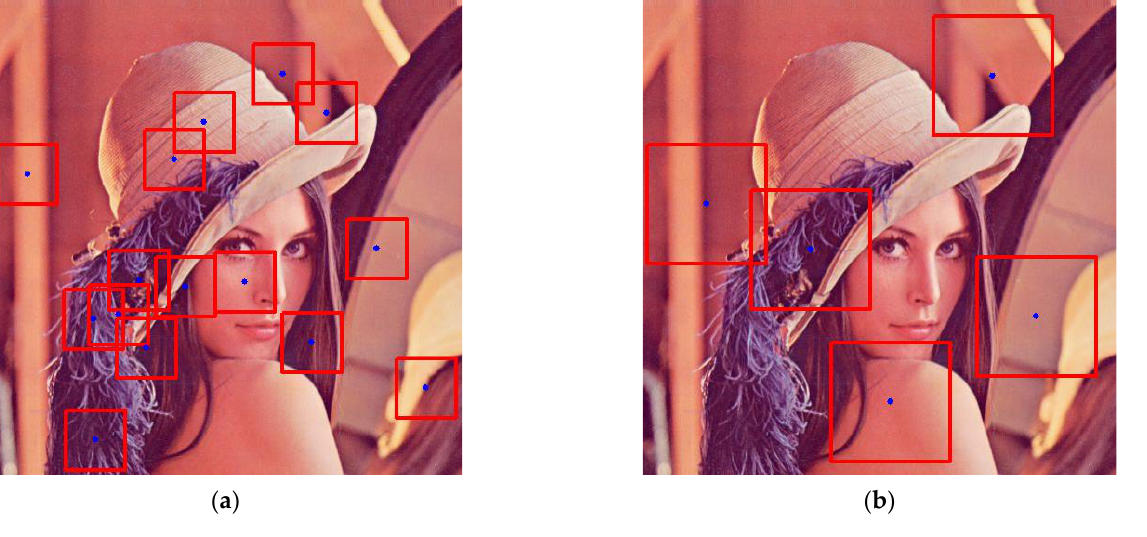
Figure 3. Creating random patches: ( a ) 15 patches with dimensions of 64 × 64 randomly positioned all over the source image (overlapping of patches is allowed); ( b ) 5 patches with dimensions of 128 × 128 randomly positioned all over the source image (overlapping of patches is allowed for up to 10% of the patch’s area, and a maximum of 50 attempts is allowed in order to find patches that fu lfill the requested conditions).